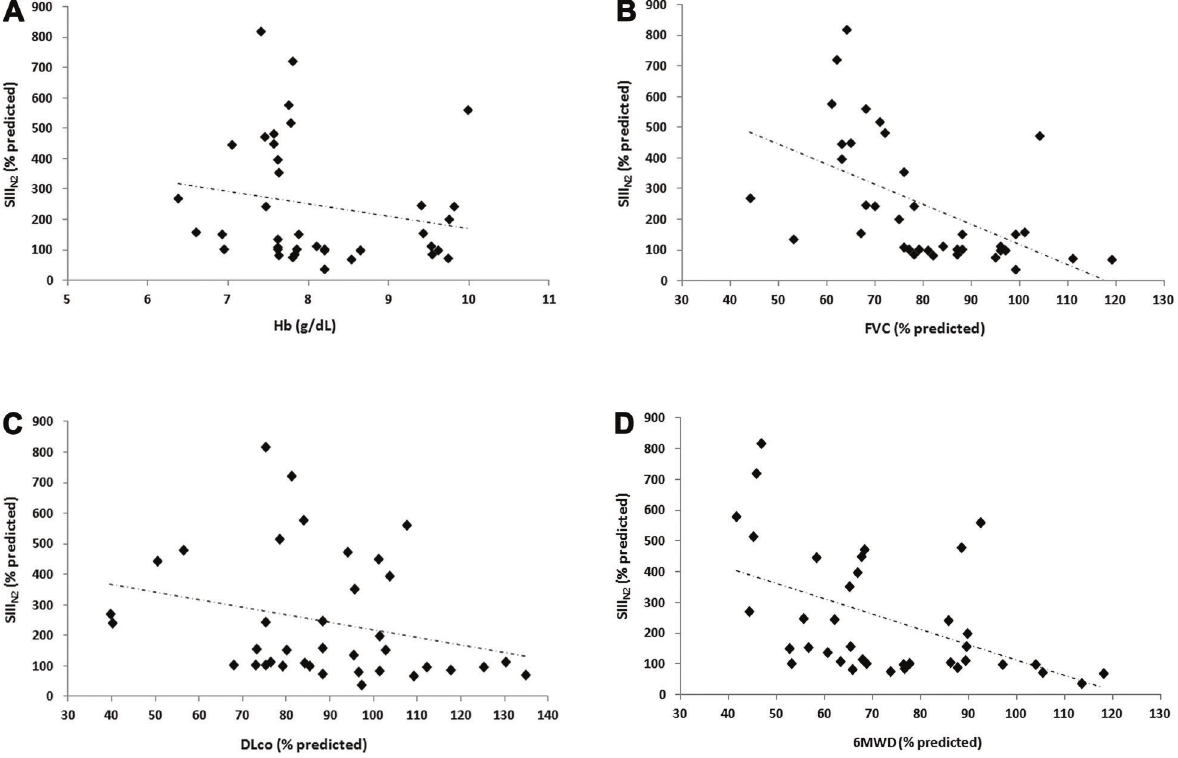
Figure 1. Spearman correlation of phase III slope of the nitrogen single-breath washout test (SIII N2 ) with A , hemoglobin (Hb) (r s = – 0.344; P=0.034); B , forced vital capacity (FVC) (r s = – 0.671; P o 0.0001); C , diffusing capacity for carbon monoxide (DLco) (r s = – 0.376; P=0.019); and D , the 6-min walking distance (6MWD) (r s = – 0.554;